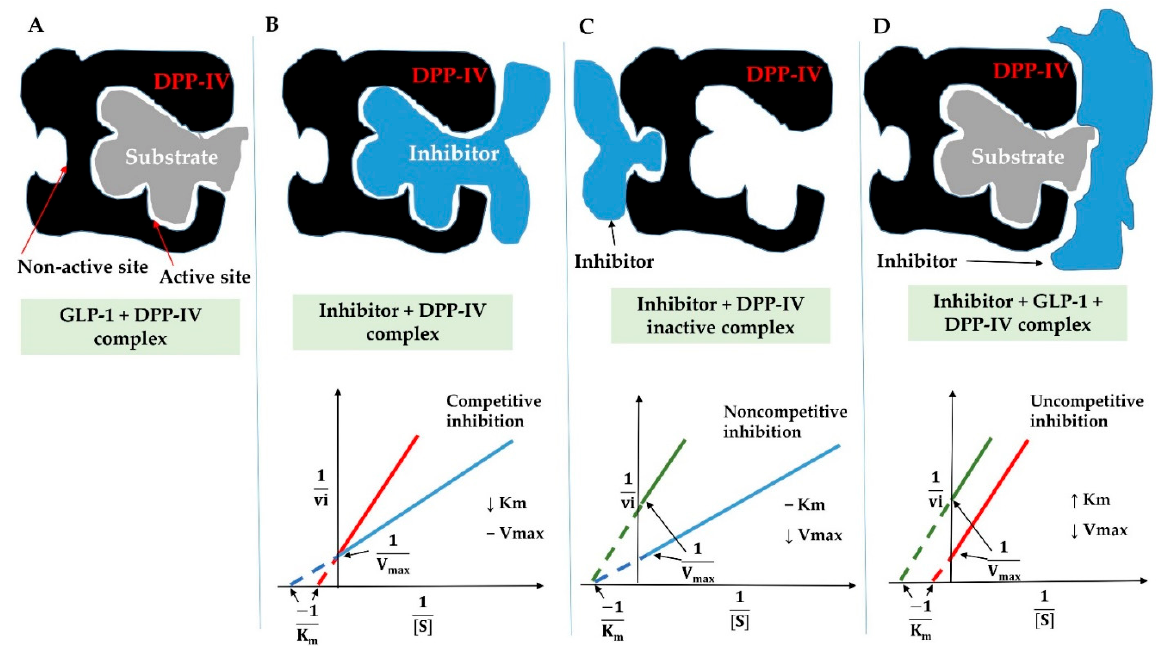
Figure 6. Inhibition modes of DPP-IV inhibitory peptides. ( A ) The complexion of the natural substrate (GLP-1) of DPP-IV and DPP-IV enzyme. DPP-IV inhibitors prevent DPP-IV enzymes from cleavage substrates through binding to active sites of DPP_IV as ( B ) competitive inhibition presenting via the Lineweaver-Burk plot results with a stable Vmax value and decreasing Km value based on the inhibitor concentrations; interaction at the secondary binding sites of DPP-IV as ( C ) non-competitive inhibition that performs a constant Km value and reducing Vmax value; and ( D ) uncompetitive inhibition that shows increasing Km value and decreasing Vmax value depending on the levels of inhibitors.